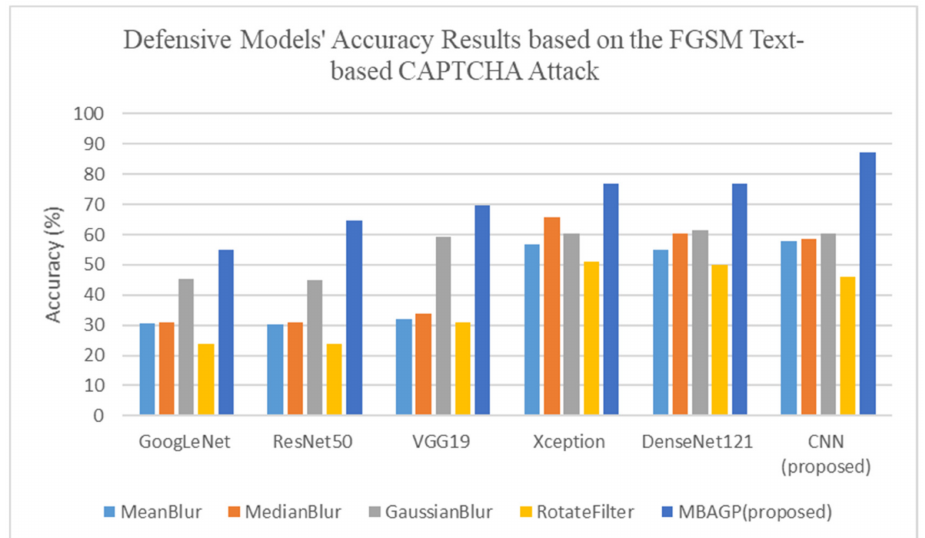
Figure 19. Comparison results of the testing accuracies obtained by the defense models based on the FGSM text-based CAPTCHA attack, in terms of the proposed MBAGP-CNN model.